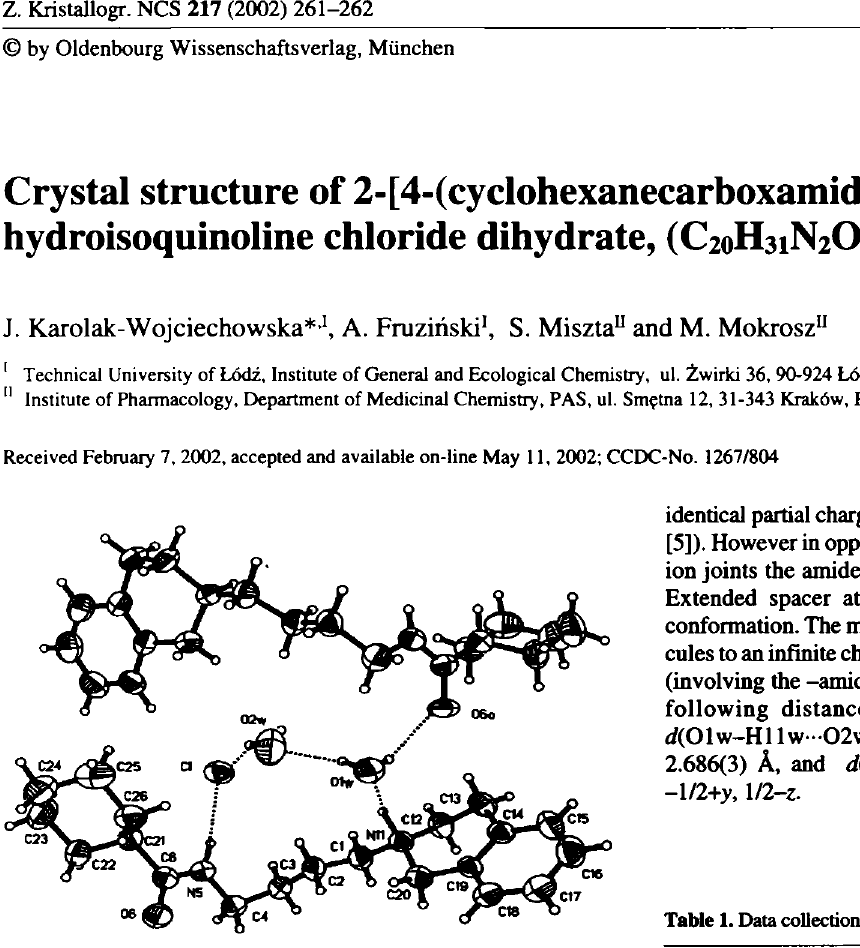
Table 1. Data collection and handling.